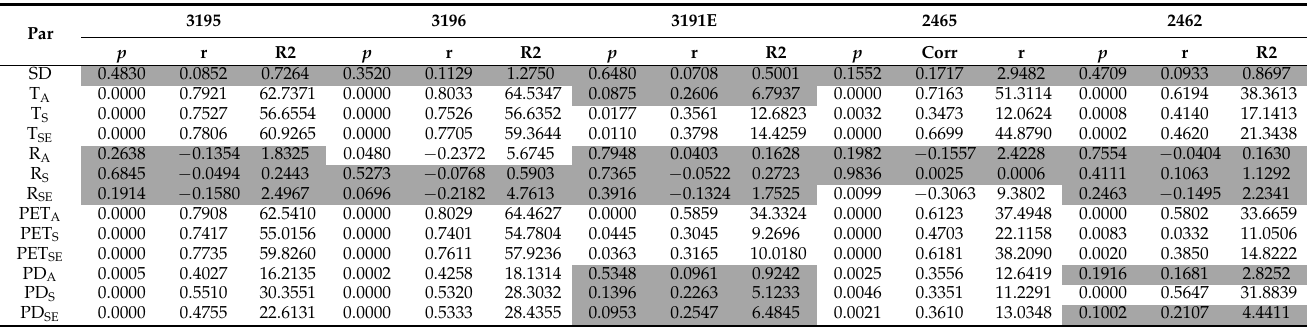
Table 3. Simple regressions and ANOVAs for the meteorological stations and parameters